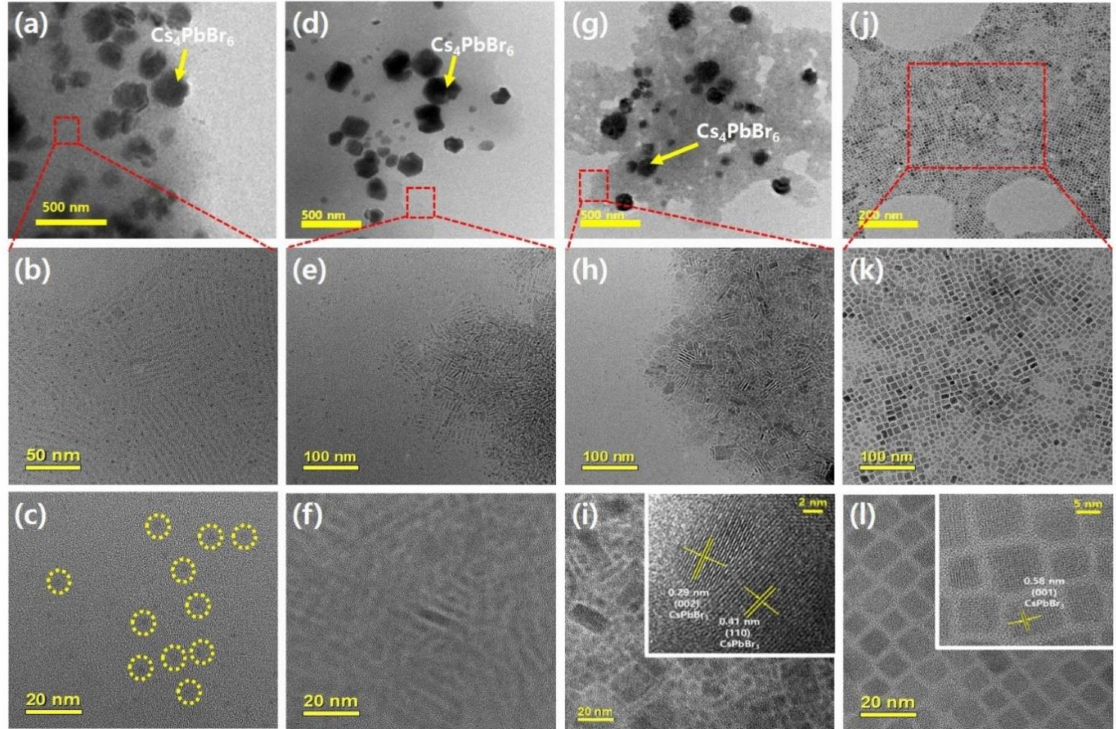
Figure 2. Transmission electron microscopy (TEM) images of the all-inorganic metal halide per- ovskite nanocrystals (IPeNCs) in ( a – c ) prepolymer-0, ( d – f ) prepolymer-25, ( g – i ) prepolymer-50, and ( j – l ) toluene-25. ( a , d , g , j ) are low-magnification images, and ( b , c , e , f , h , i , k , l ) are enlarged images of the CsPbBr 3 nanoparticles. The yellow dotted circles in ( c ) indicate small amorphous CsPbBr 3 nanoparticles. The insets in ( i , j ) show the lattice constants of CsPbBr 3